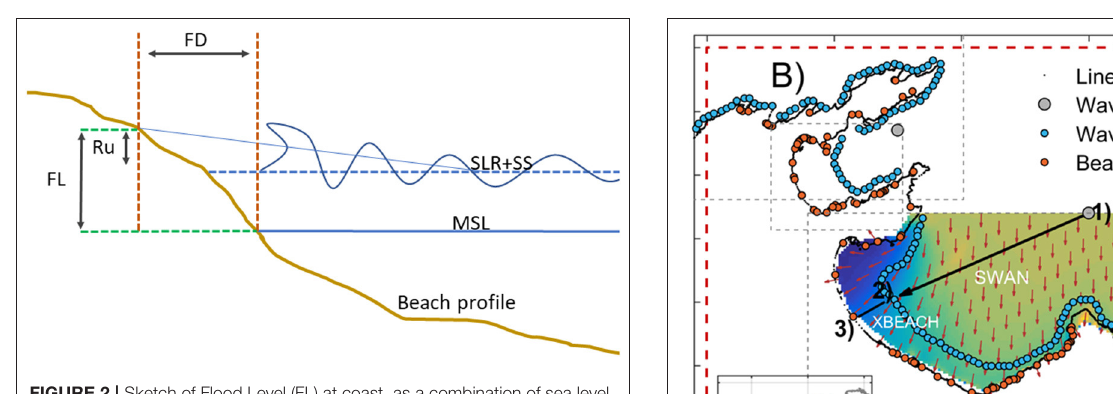
FIGURE 2 | Sketch of Flood Level (FL) at coast, as a combination of sea level rise (SLR), storm surge (SS) and wave runup (Ru). The flood distance, denoted in the figure as FD, is indirectly obtained with FL and the beach slope.